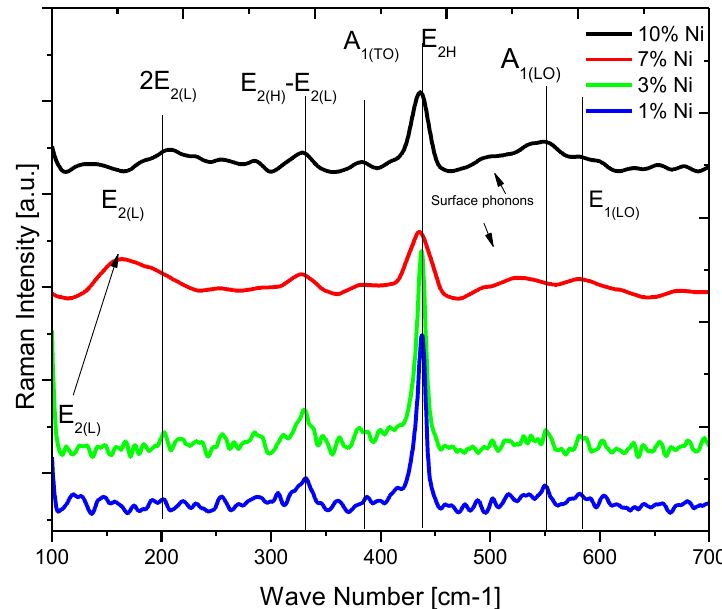
Figure 7. Room temperature micro Raman spectra for ZnNiO nanoparticles recorded in the confocal mode. Vertical lines show the positions of di ff erent normal modes of Raman vibrations. Ni content in the ZnNiO samples are written by Ni-1%, -3%, -7% and -10%, respectively, and the corresponding Raman spectra are plotted in blue, green, red and black colors.